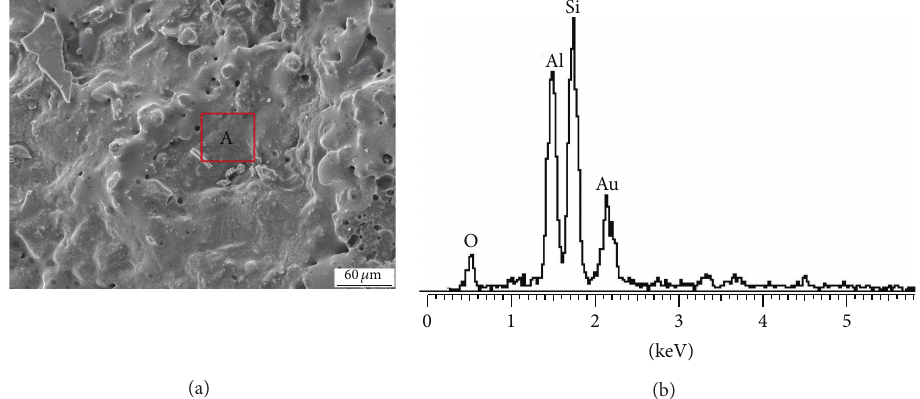
Figure 6: SEM images and EDS patterns of sample M4 (12% silicon added) eroded at 1200 ∘ C: (a) SEM micrographs of the surface of sample and (b) EDS result of area